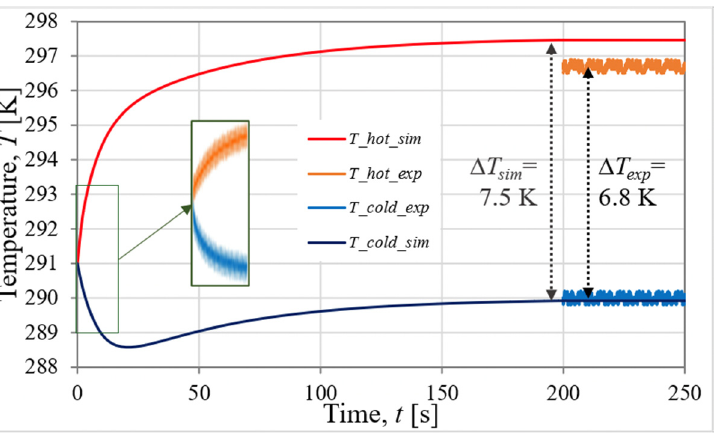
Figure 38. Comparison between the multi-physics results and experimental measurements [19,87].